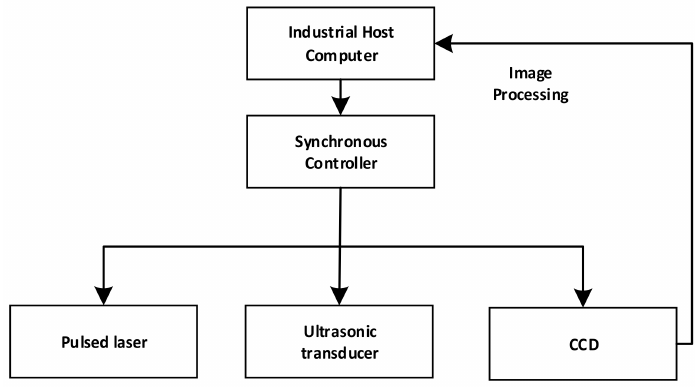
Figure 5. Schematic of the synchronous control